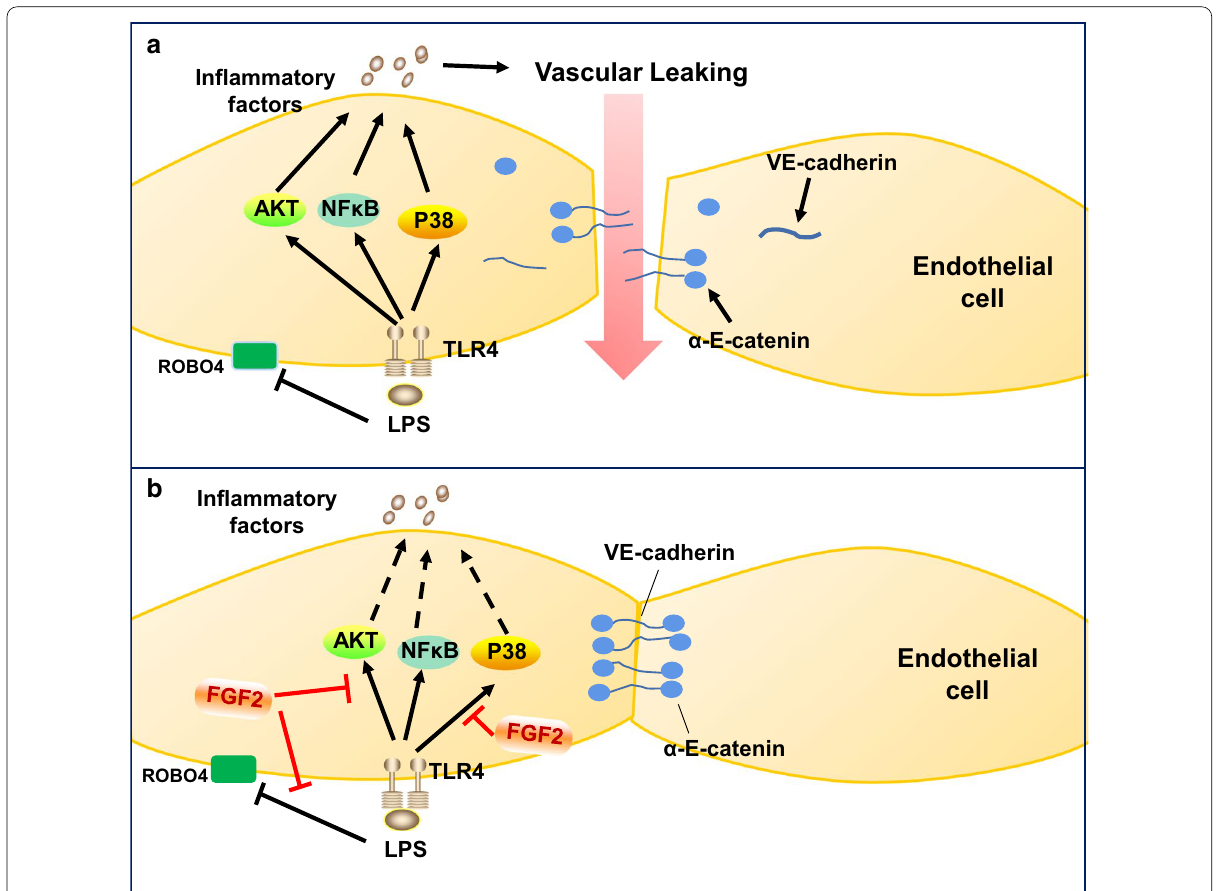
Fig. 7 FGF2 alleviates the inflammation and vascular leakage in sepsis. FGF2 reduces vascular leakage caused by relieving inflammation through AKT/P38/NF-κB pathways. a LPS combined with TLR4 activates AKT/P38/NF-κB pathways to release amount of inflammatory factors leading to VE-cadherin/α-E-catenin disruption and endothelial cell barrier malfunction. b FGF2 enhances vascular barrier function against inflammatory factors production by inactivating AKT/P38/NF-κB pathways and stabilizing VE-cadherin/α-E-catenin at the cell